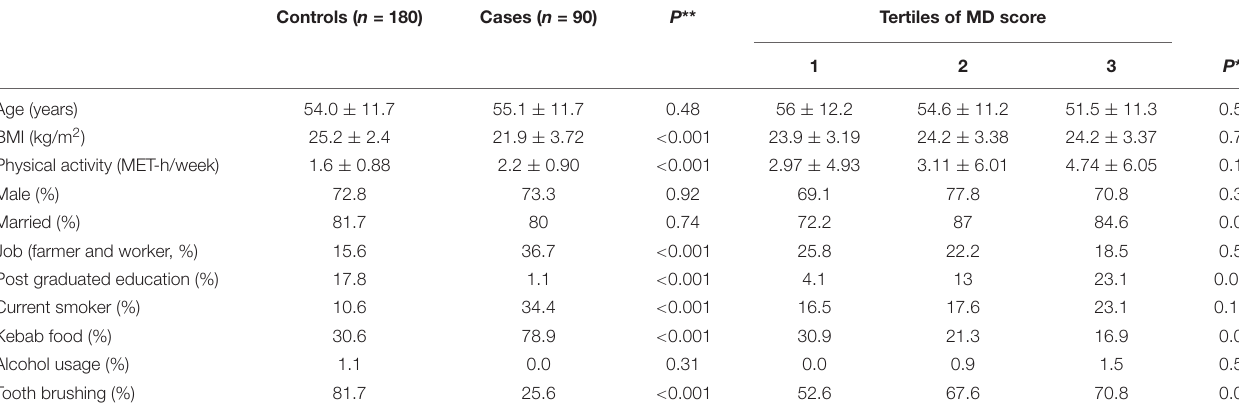
TABLE 1 | General characteristics and dietary habits of study participants. Controls ( n = 180)